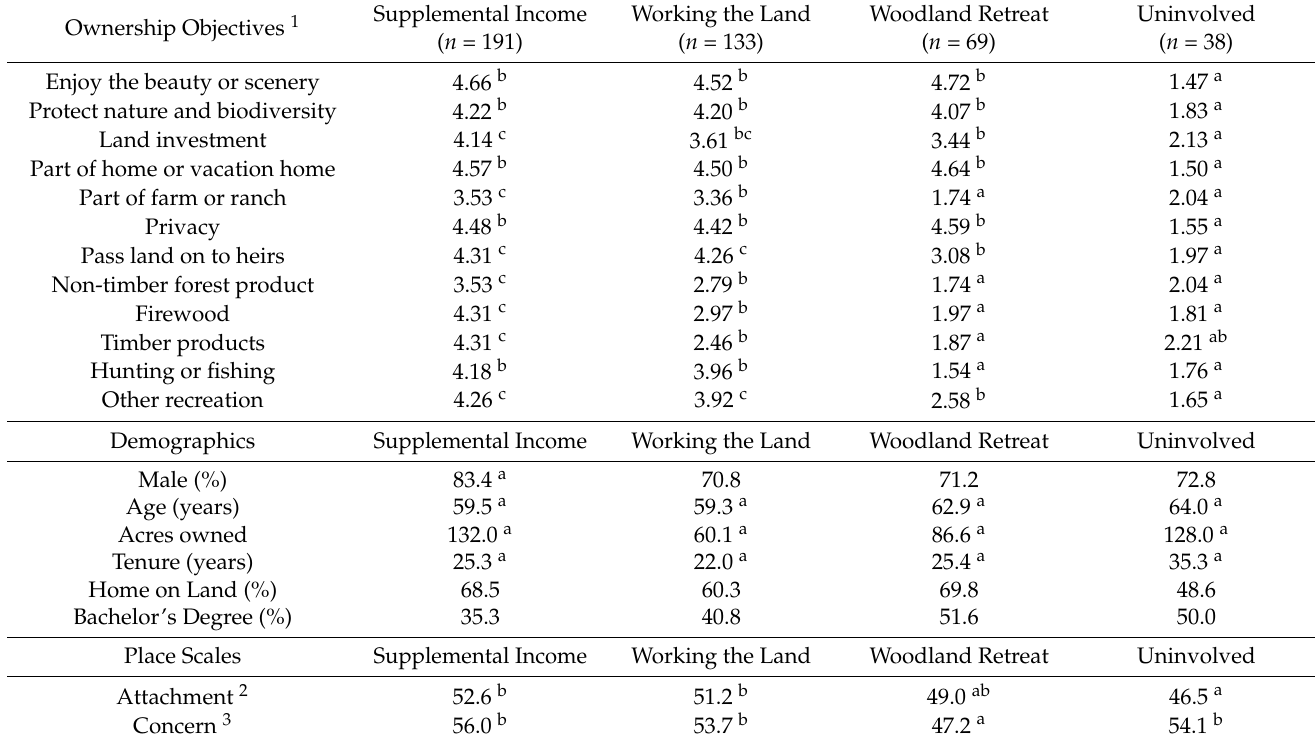
Table 4. Landowner